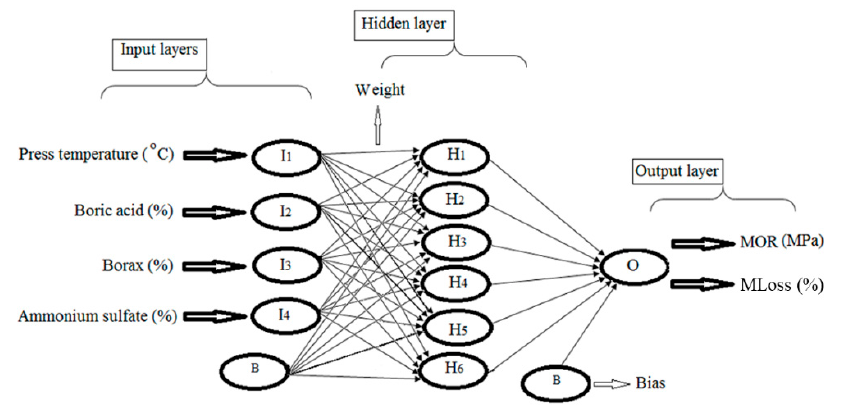
Figure 4. The structure of the ANN model to compute the fiberboard properties under fire conditions. Adapted with permission from ref. [98]. Copyright 2020 Open Access & Springer. Table 2. The statistical metrics of the ANN model used to predict the modulus of rupture (MOR) and